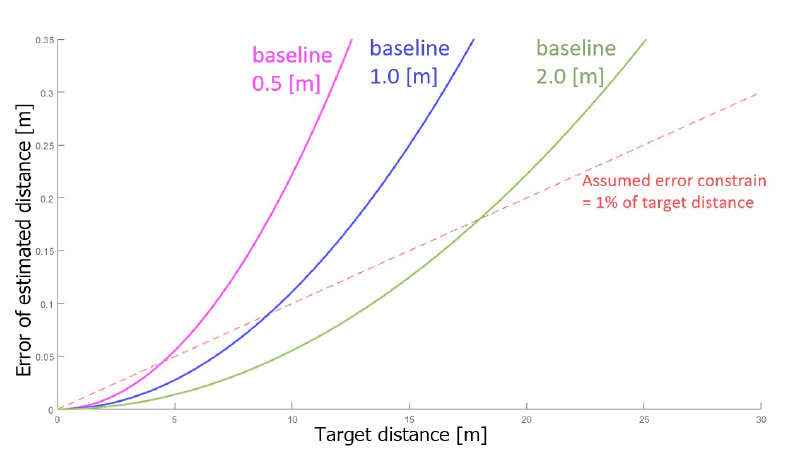
Figure 2. The theoretical value of estimation error on y-axis vs. target distance on x-axis. The graph shows the estimation error of three different baselines shown in three solid color lines. For reference, the virtual error constrain of 1% of the target distance is shown in a dashed red line.